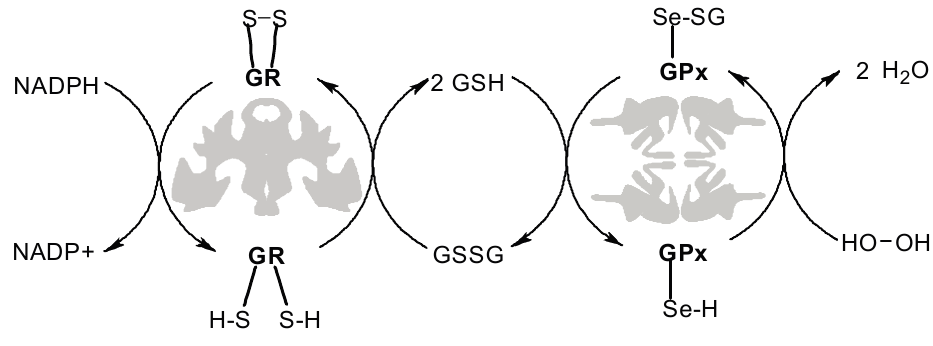
Figure 1. Diagram of the glutathione enzyme system [4] (© IUPAC,